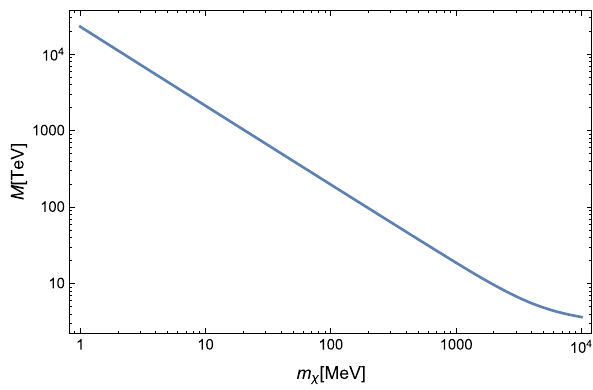
Fig. 1 The magnetic dipole coupling scale M = M d / a m as a function of dark matter mass m χ in the range 1MeV ≤ m χ ≤ 10GeV